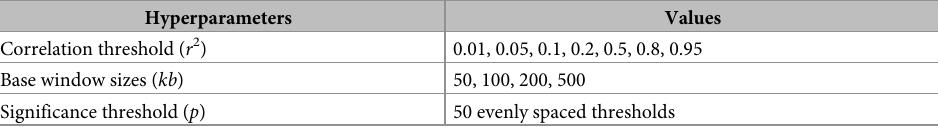
Table 2. A grid of hyperparameters used in the SCT algorithm.